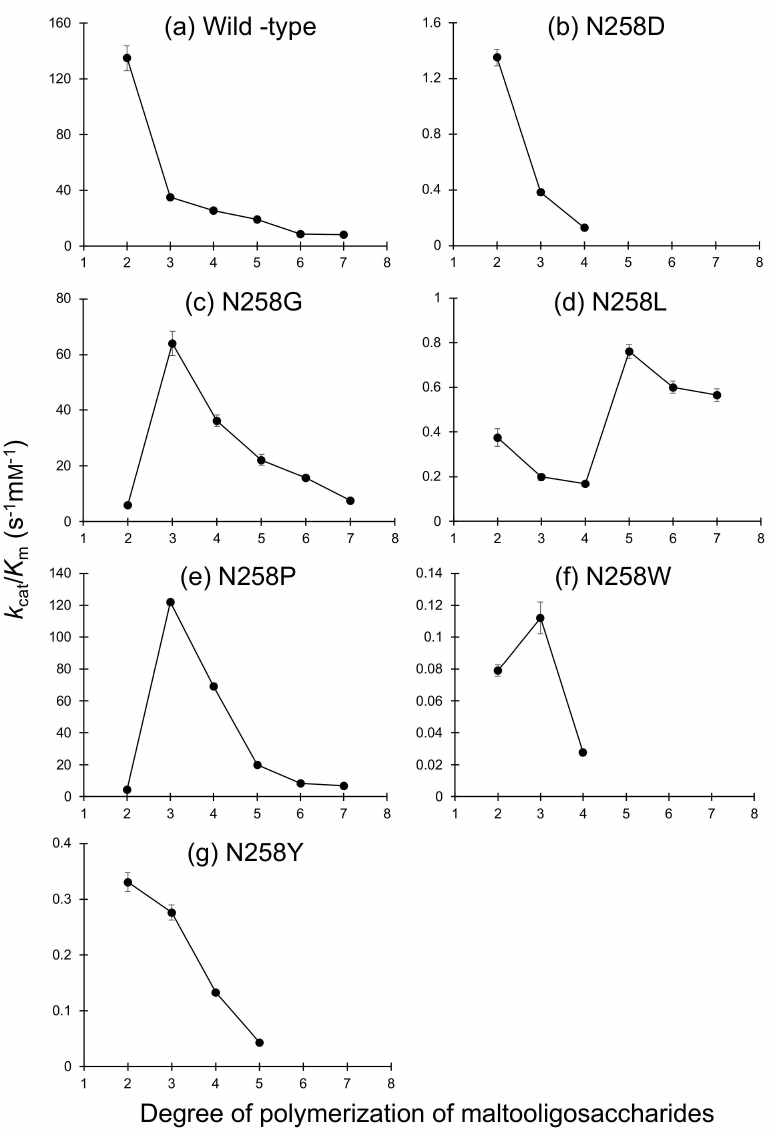
Figure 4. Substrate chain-length specificity of Asn258 mutants of BspAG13_31A. ( a ) Wild